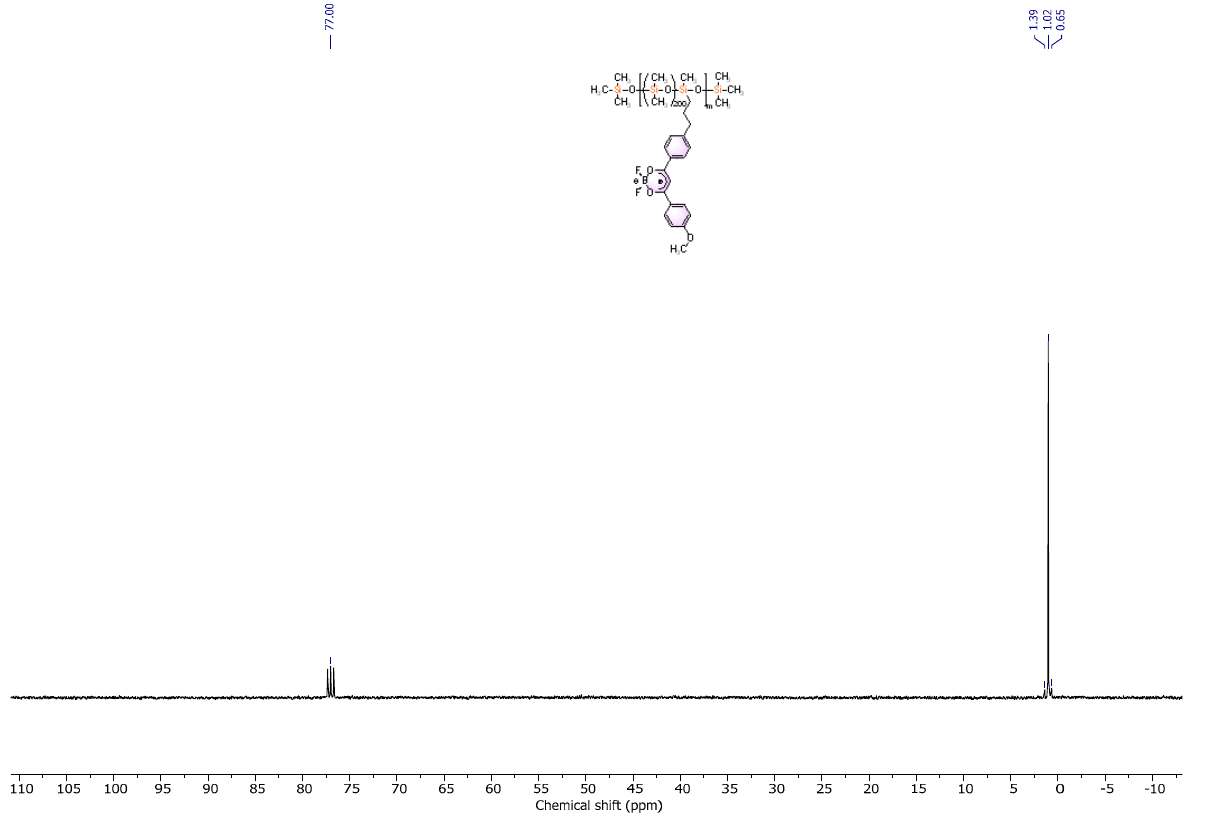
Figure 8. 13 C NMR spectrum of polymer 3 b in CDCl 3 .